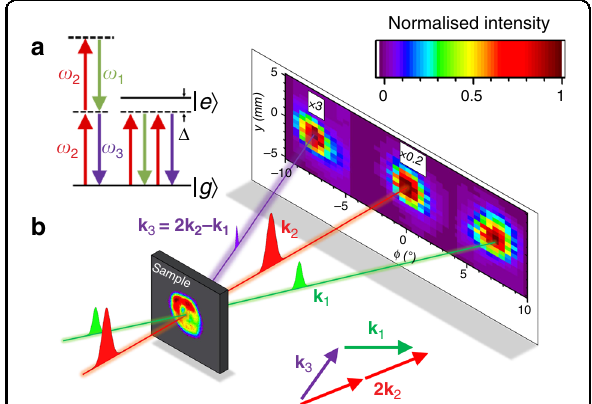
Fig. 1 The degenerate four-wave mixing geometry. a The energy- level scheme for DFWM with two excitation photons from beam 2, a stimulated emission from beam 1 and an output photon in beam 3. The left hand process involves two virtual excited states, and the right hand permutation is the strongest near to a resonance with the ground state g j i and excited state e j i . b A camera image of the beam at the sample position is shown superimposed on the sample. Far- fi eld images were taken by scanning an iris after collimating, which requires careful conversion from space to angle. Each image has been normalised to the peak power density, and the scale factors for the far- fi eld images are indicated relative to beam 1. Note that the far- fi eld image of the beam 3 has only been scaled by a very small factor in this example (×3), i.e. the DFWM ef fi ciency is very high. The phase matching condition is also shown